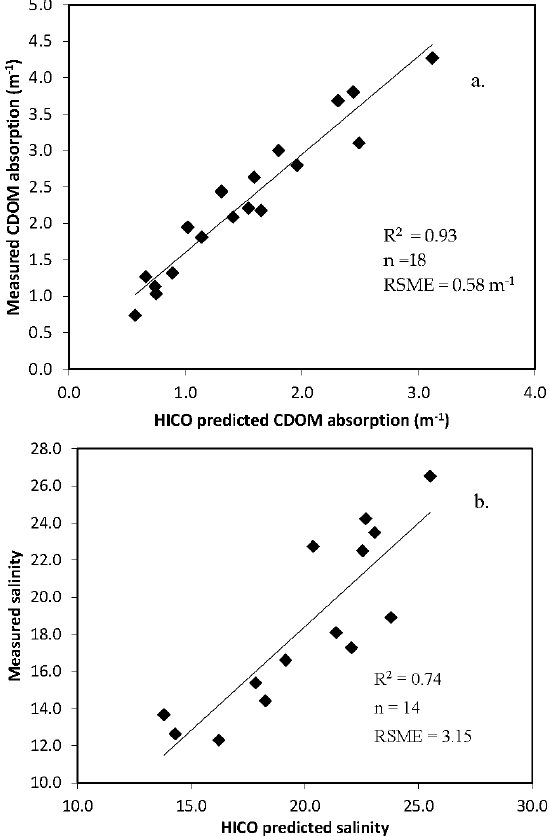
Figure 9. ( a ) Scatterplot of measured a CDOM 412 and Hyperspectral Imager for the Coastal Ocean (HICO)-derived a CDOM 412 in Pensacola and Choctawhatchee Bays (FL) estuaries from June, July, August and September 2011 ( b ) Scatterplot of measured salinities and HICO-derived salinities in the previous estuaries over the same time period. Comparisons were made using data collected within 5 h of a HICO